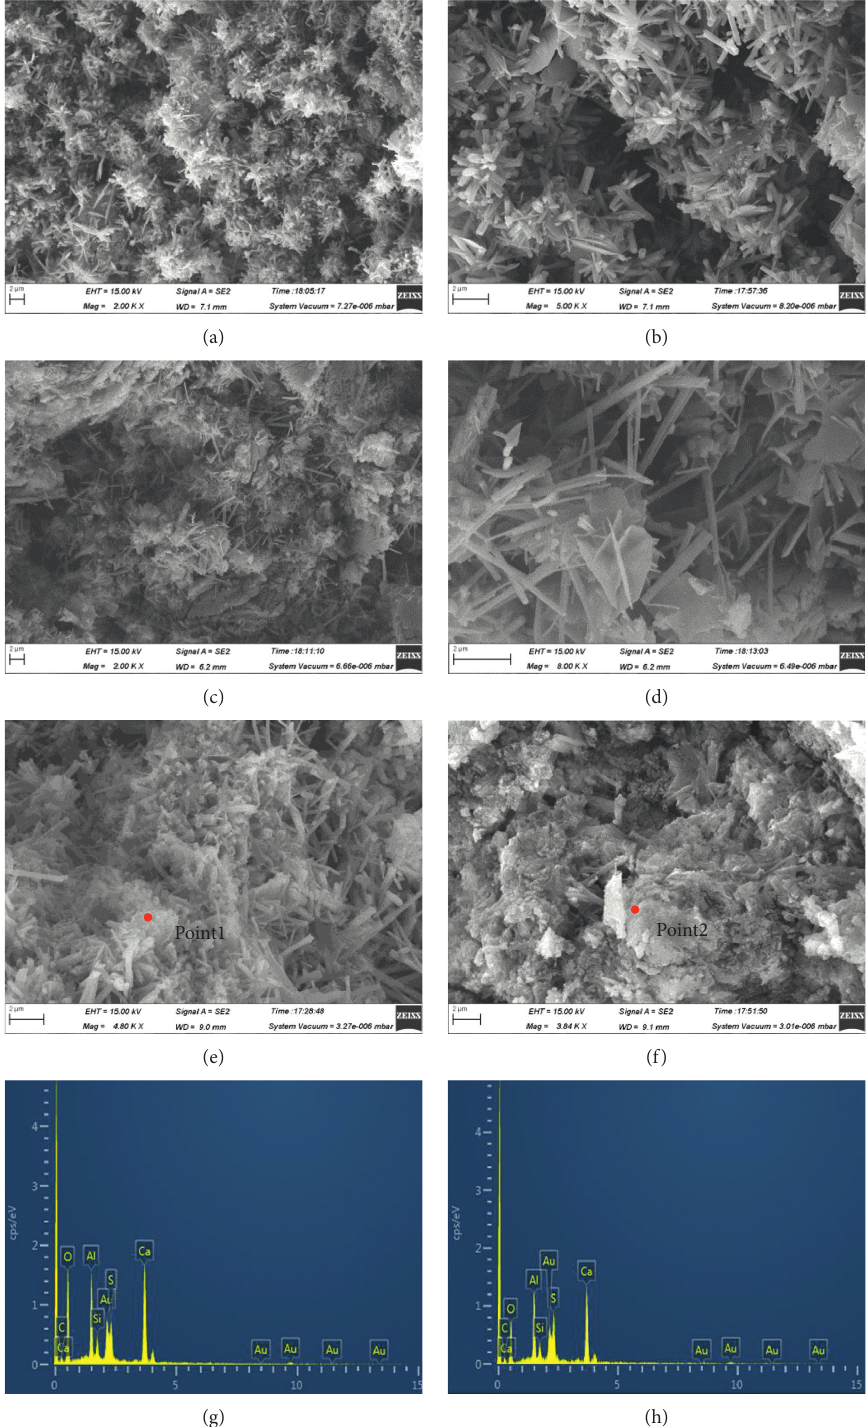
Figure 8: Effect of calcium sulfate variety on the morphology of ettringite: (a) CSA-G for 10min; (b) CSA-G for 10 min; (c) CSA-A for 10min; (d) CSA-A for 10 min; (e) CSA-G for 28d; (f) CSA-A for 28d; (g) Point 1 EDS; (h) Point 2